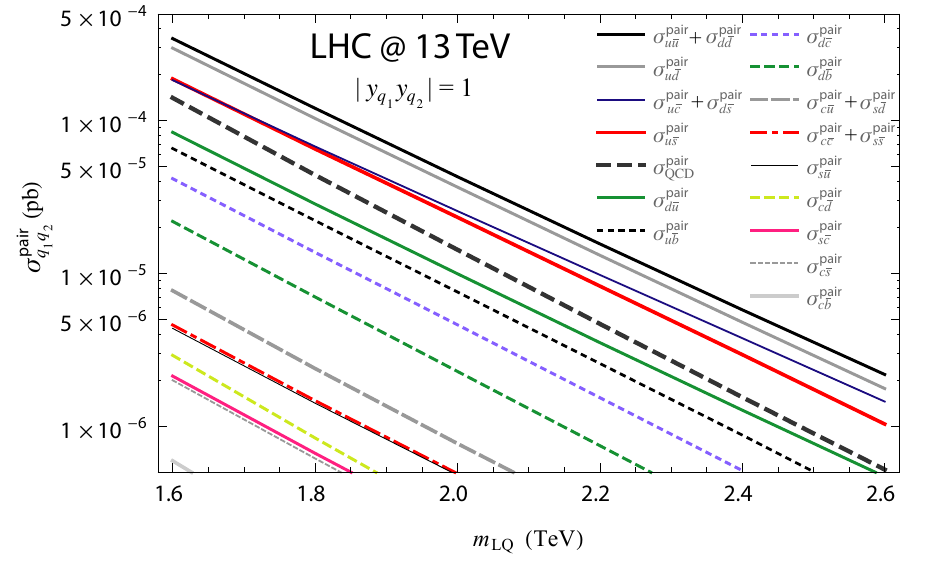
( y ) for quark- q 1 , y q 2 , m LQ q 1 q 2